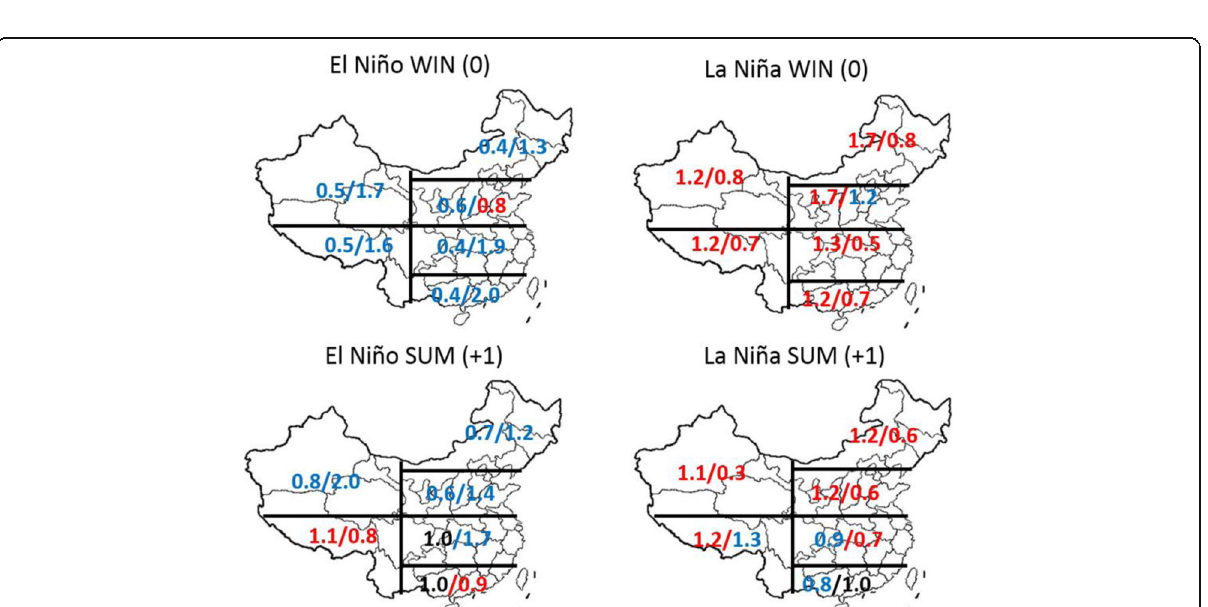
Fig. 10 Drought/flood risk in different subregions during an El Niño year ( left ) and a La Niña year ( right ). The blue color represents higher flood risk, and red color represents higher drought